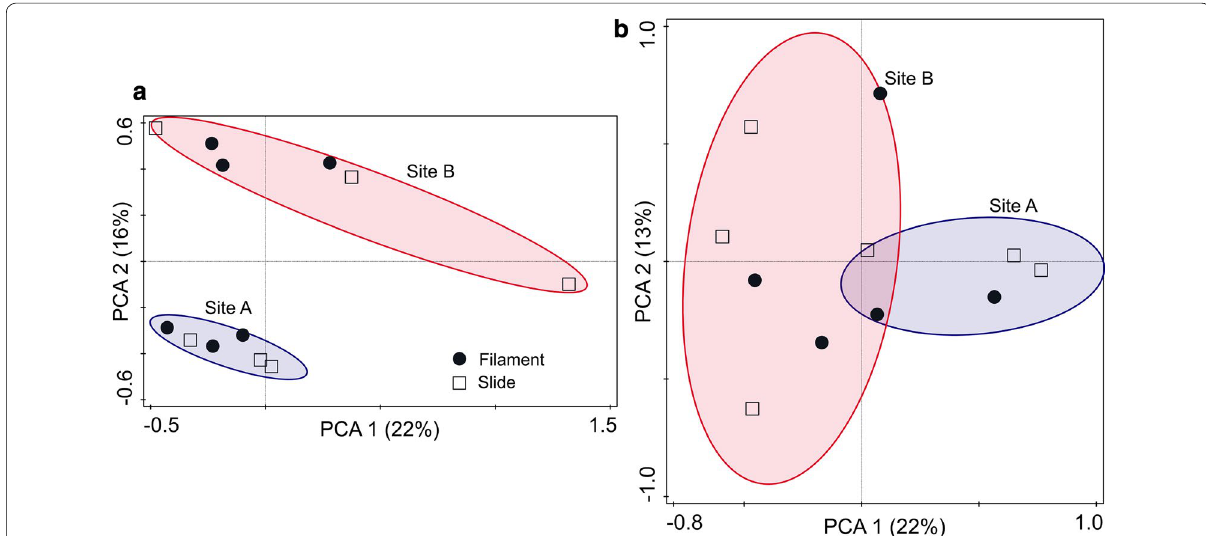
Fig. 6 Principal component analysis (PCA) showing bacterial assemblages of each substrate at different sampling events a 7-day and b 14-day (Site A lentic, Site B lotic) = =